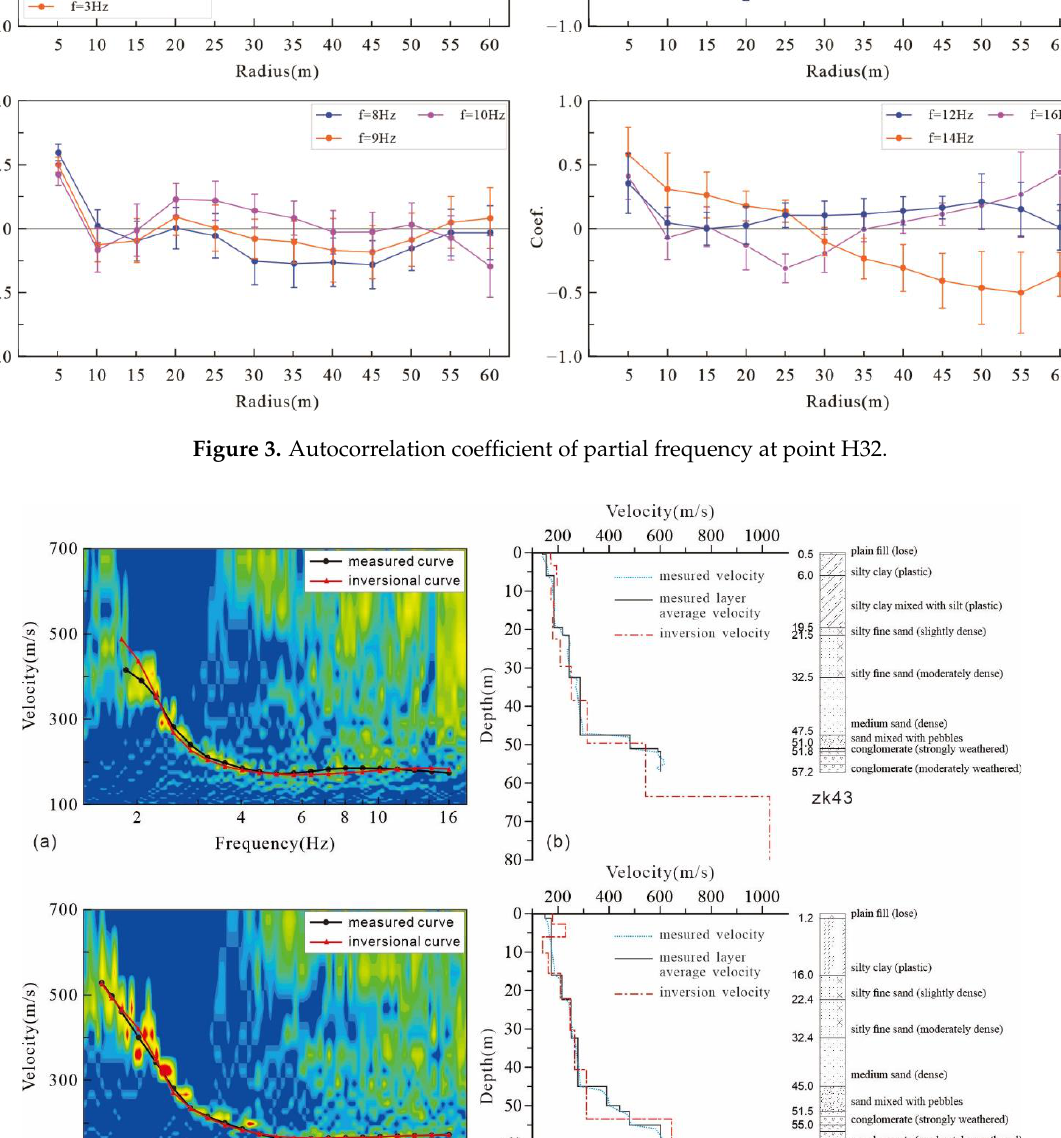
curves of H110; and ( d ) inversion model of H110 and in situ test results of